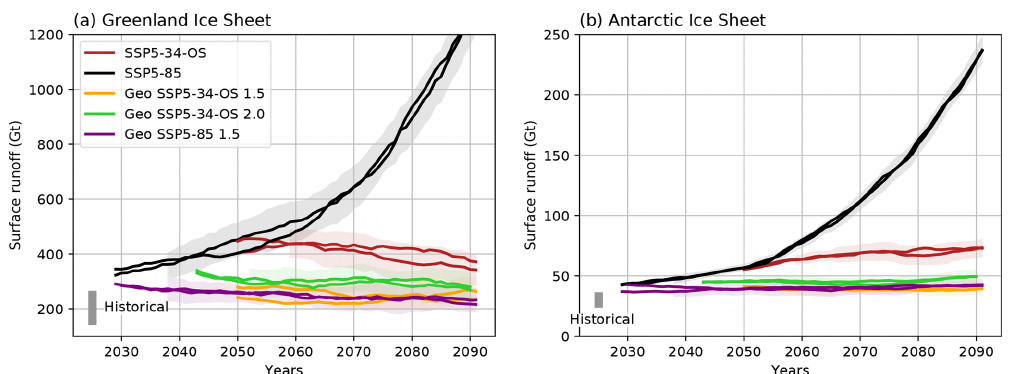
Figure A4. Mean ice sheet runoff in Gtyr − 1 . Shading indicates standard deviation of one of the members, calculated after detrending the time series using empirical model decomposition. A 20-year running mean has been applied to filter out the high year-to-year variability. The area of integration is the same as in Fig. 10. The solid grey bar indicates the ± 1SD (standard deviation) runoff over the period 1960–1999 in CESM2 (WACCM) for